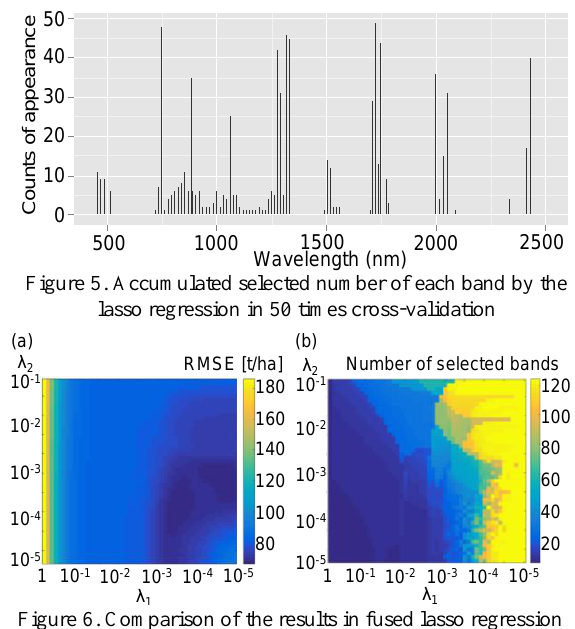
Figure 6. Comparison of the results in fused lasso regression (a) effect of 𝜆 1 and 𝜆 2 on the overall prediction accuracy, (b) the number of selected bands in 𝜆 1 and 𝜆